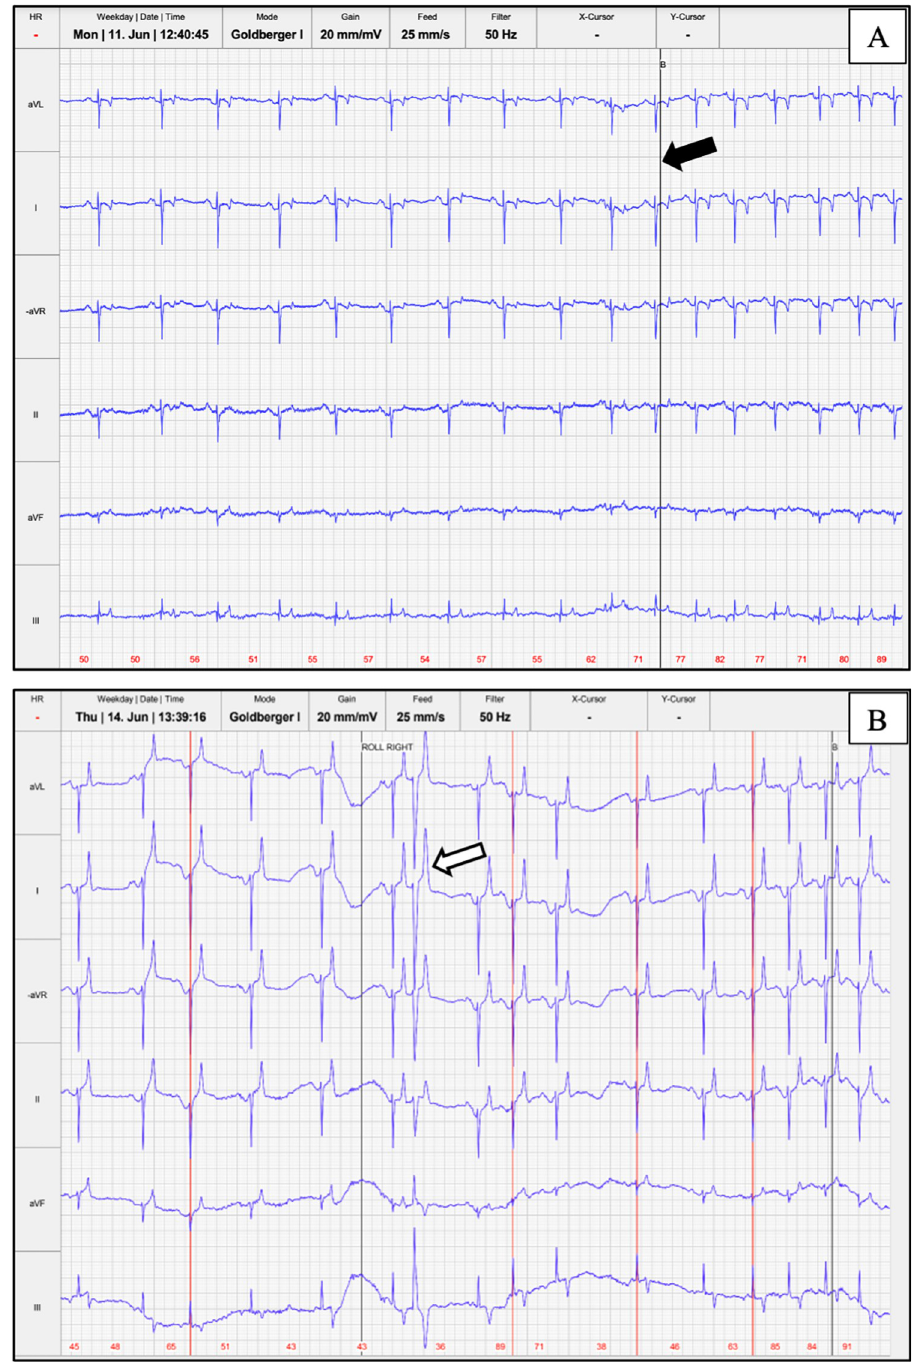
Fig 5. Telemetric ECG recordings from two SB dolphins. (A) Demonstrating the normal, pronounced respiratory sinus arrhythmia, with timing of the breath marked with the black line (black arrow). (B) Demonstrating respiratory sinus arrhythmia with an isolated ventricular premature complex (white arrow). Lead I is modified to the base-apex lead, and the primarily negative depolarization in base-apex and Lead II is normal for this type B cardiac conduction system. The paper speed is 25mm/s and gain is 20mm/mV, with the sweep covering 16 seconds.